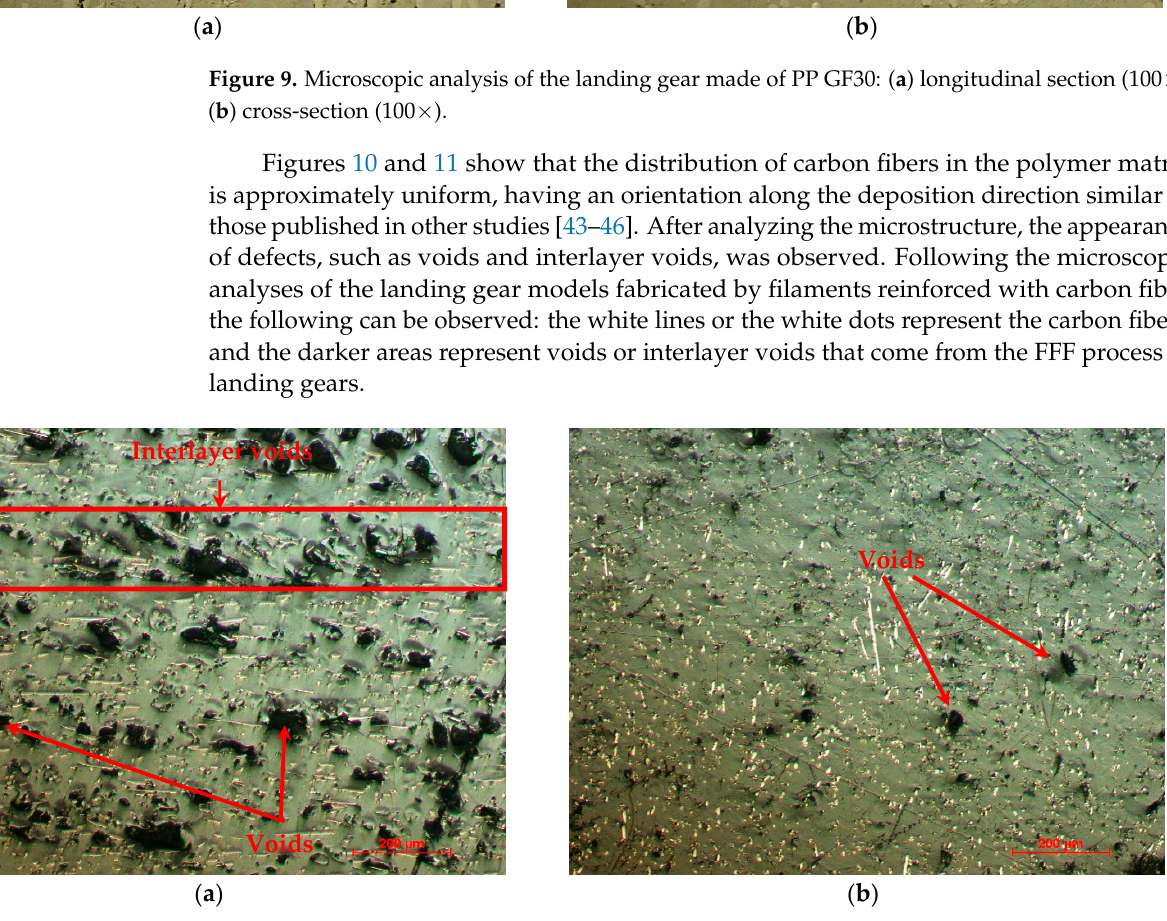
Figure 9. Microscopic analysis of the landing gear made of PP GF30: ( a ) longitudinal section (100×); ( b ) cross-section (100×).